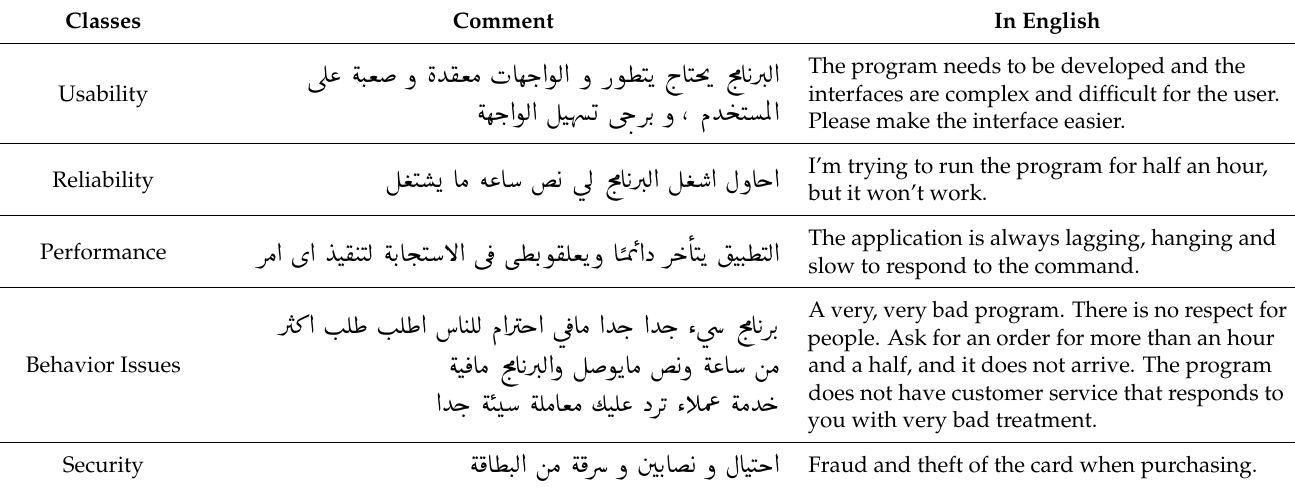
Table 6. Examples of user comments and classes of